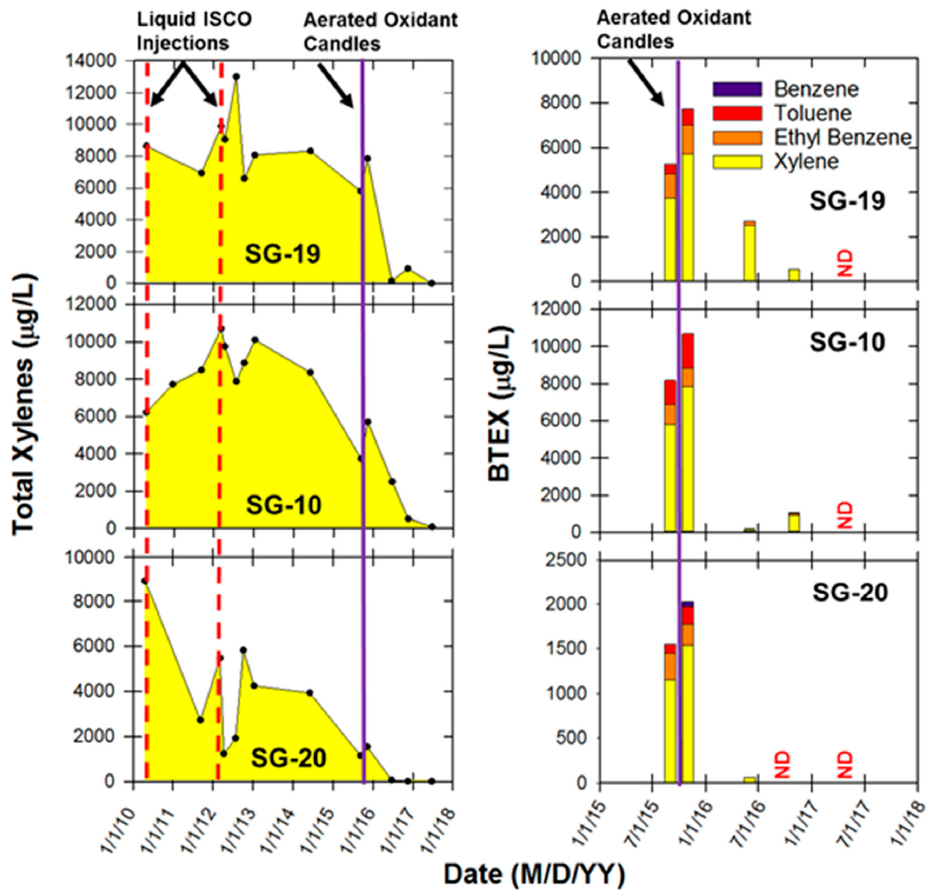
Figure 4. ( Left ) Historical changes in total xylene concentrations at the Freeman site following treatments with two liquid oxidant injections and aerated oxidant candles and ( Right ) temporal changes in BTEX concentrations following installation of aerated oxidant candles.